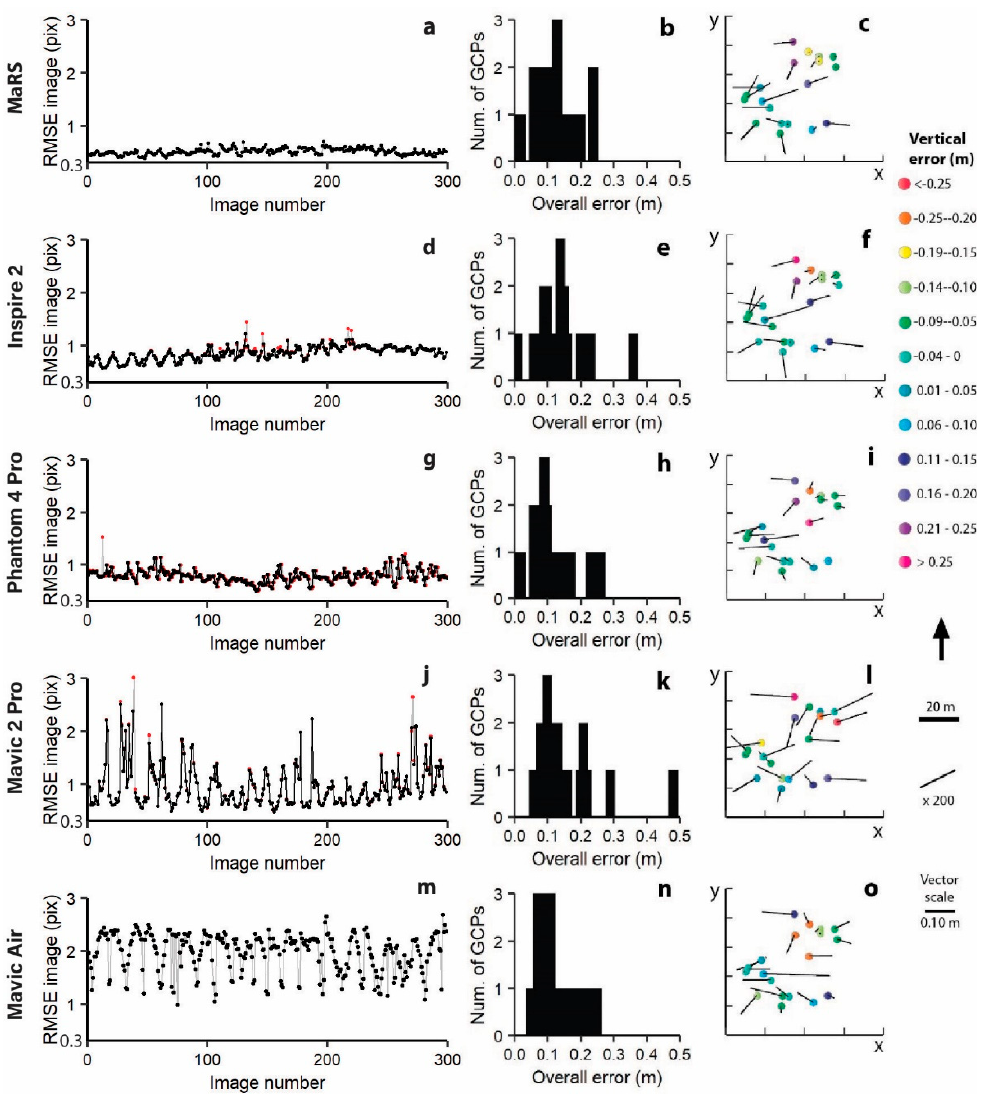
Figure 4. Assessment of network quality control for MaRS ( a – c ), Inspire 2 ( d – f ), Phantom 4 Pro ( g – i ), Mavic 2 Pro ( j – l ), and Mavic Air ( m – o ). ( a , d , g , j , m ) Root mean square error (RMSE) tie point image residuals in pixels for each image in each of the five networks where red indicates before image removal and black indicates after image removal. GCPs included as control in the bundle adjustment with a distribution of their overall error (xyz) ( b , e , h , k , n ), and 3D errors and GCPs where the vectors are the horizontal error magnified by 200 ( c , f , i , l , o ). The image root mean square error (RMSE) is the square root of the averaged squared distances between the projected reconstructed valid tie points and their corresponding original projections detected on the photos.